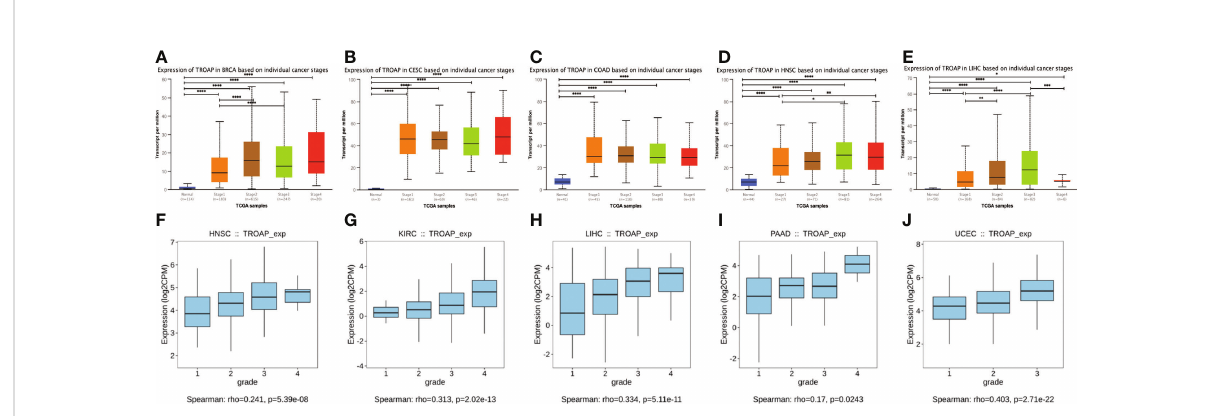
FIGURE 2 The transcriptional expression of TROAP in pan-cancer strati fi ed by stage and grade, respectively. (A – E) The association between TROAP transcriptional level and various tumor stages in breast invasive carcinoma(BRCA), cervical squamous cell carcinoma and endocervical adenocarcinoma (CESC), colon adenocarcinoma (COAD), head and neck squamous cell carcinoma (HNSC) and liver hepatocellular carcinoma (LIHC) using TISIDB database; (F – J) The correlation between the transcriptional level of TROAP and different tumor grades HNSC, kidney renal clear cell carcinoma (KIRC), LIHC, pancreatic adenocarcinoma (PAAD), and uterine corpus endometrial carcinoma (UCEC) using UALCAN online tool. All *: P < 0.05; **:P < 0.01; ***: P < 0.001; and **** P <